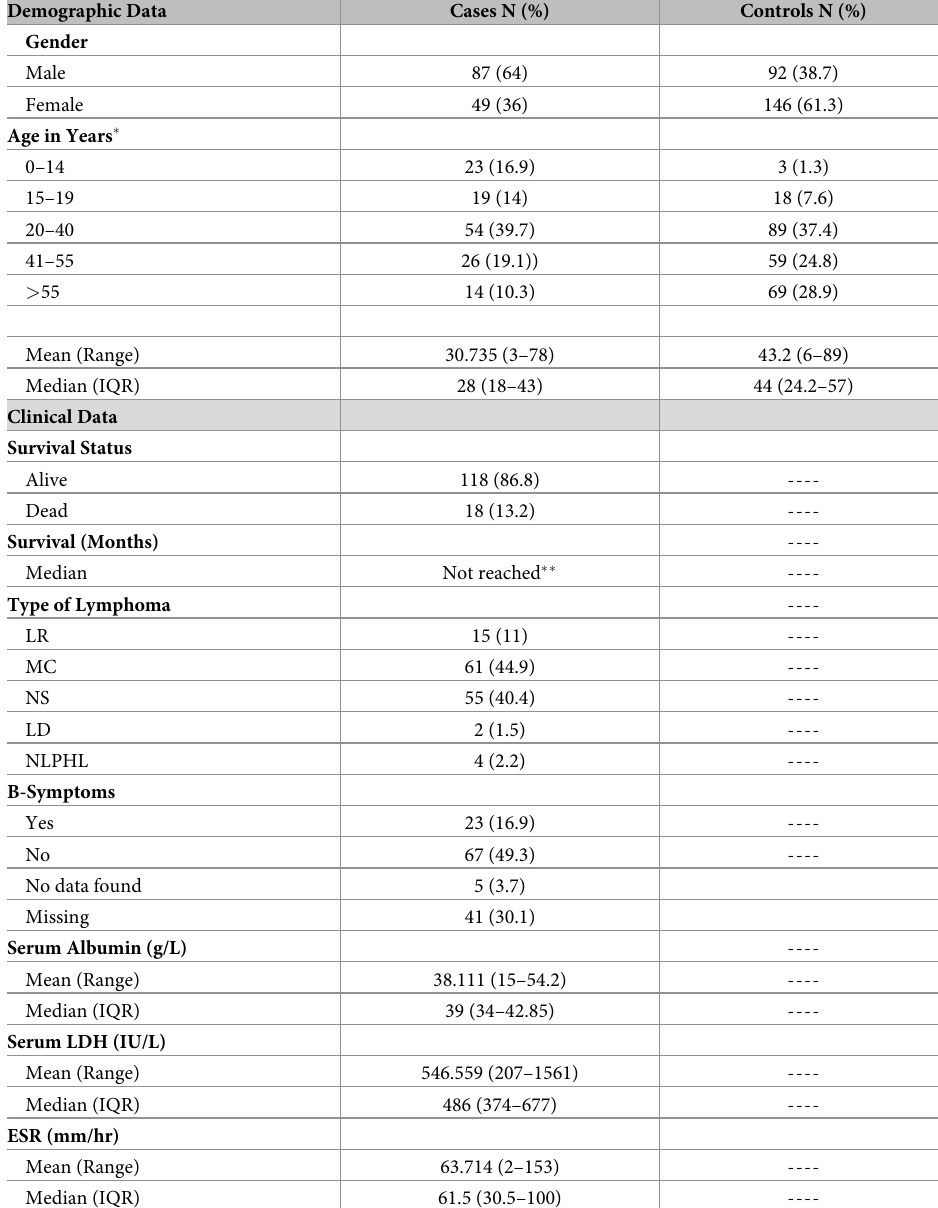
Table 2. Demographic and clinical data of the 136 cases and 238 controls enrolled in the study. Demographic Data